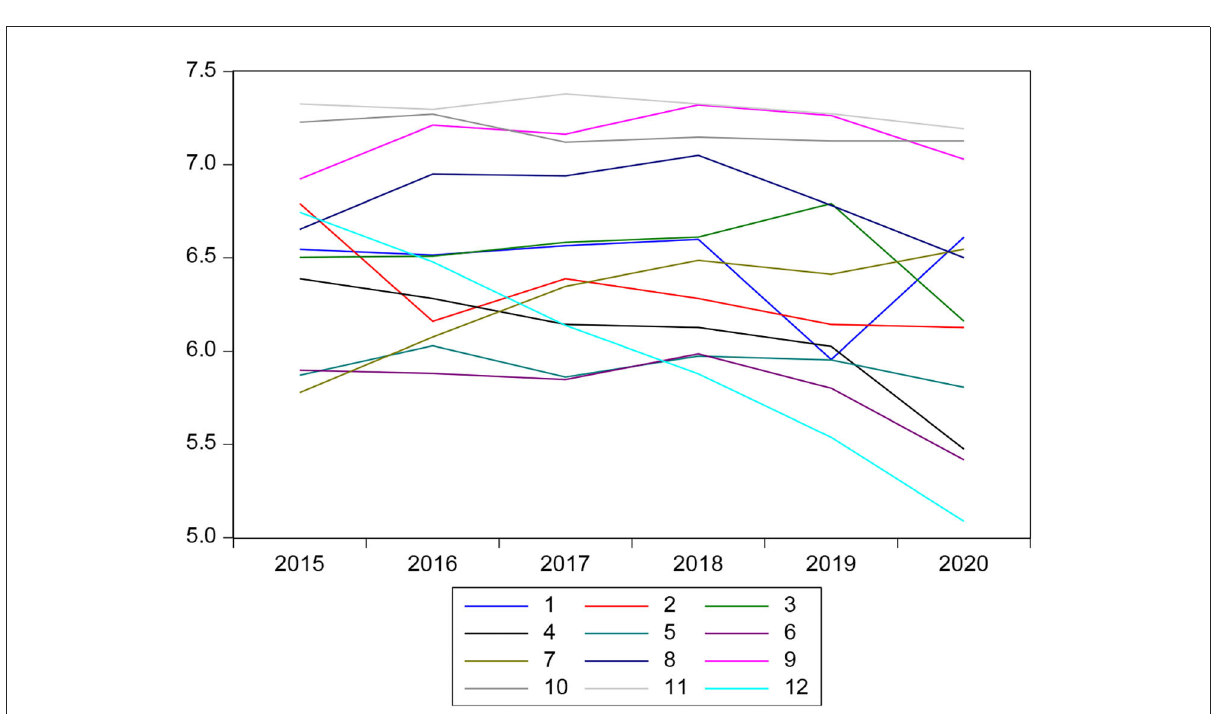
FIGURE5 Crime behavior in the